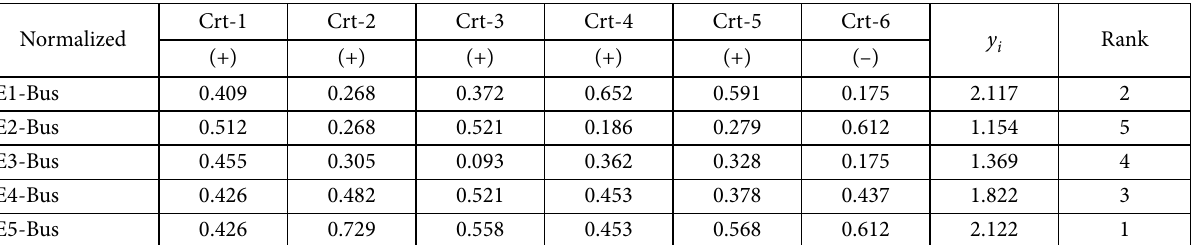
Table 4. Ratio system approach and ranking